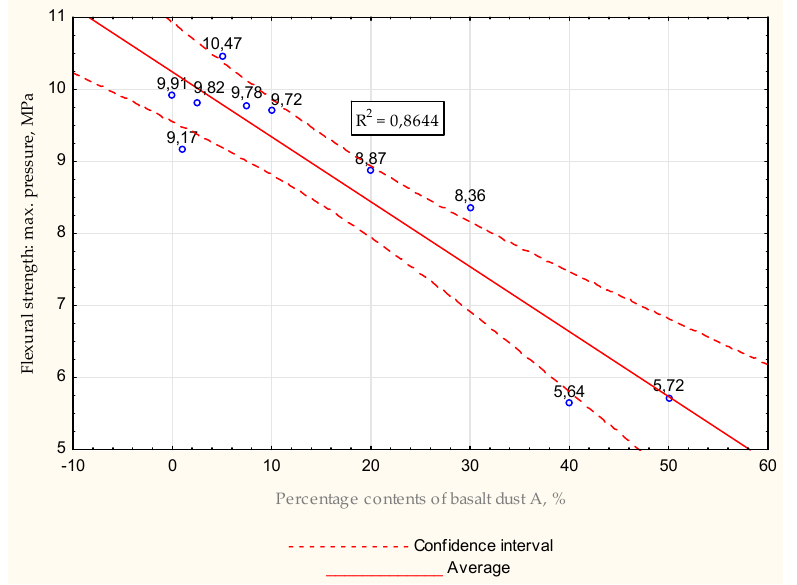
Figure 16. Average values received during flexural strength tests for water − mix ratio = 0.5, maximal pressure.